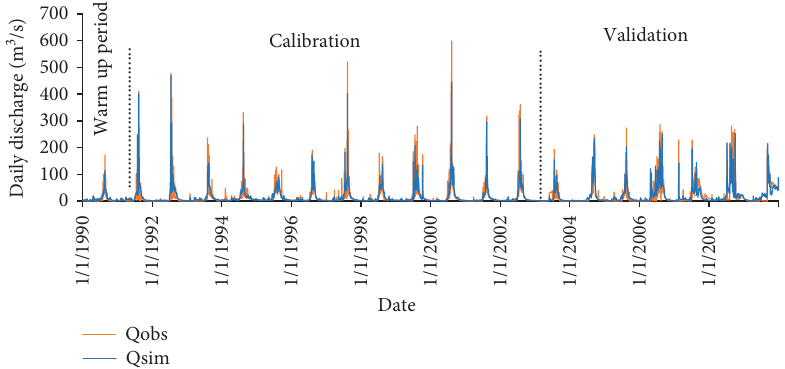
Figure 16: Observed and simulated stream flow at Kesem dam.